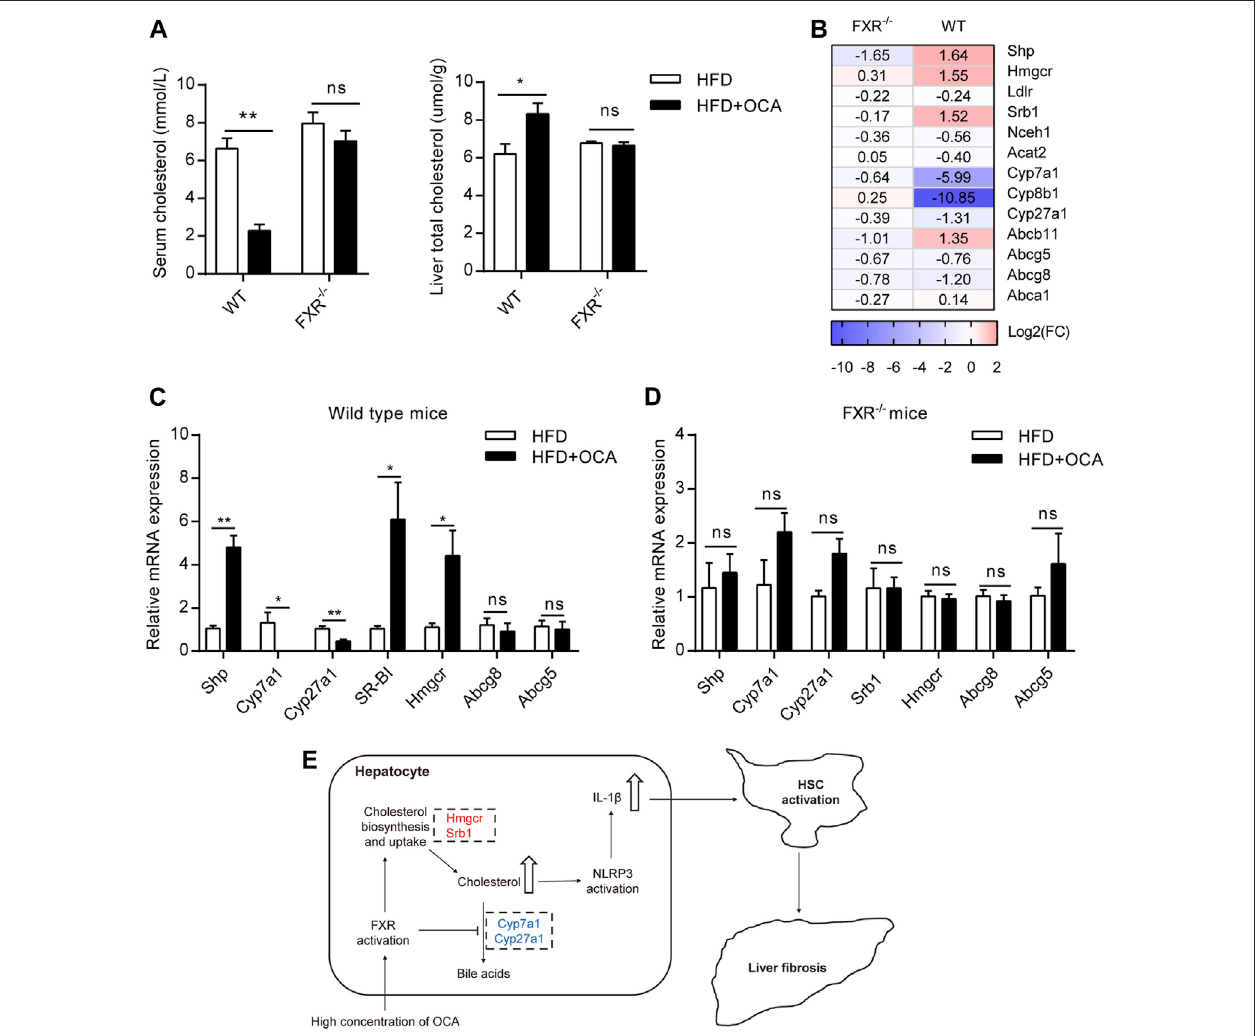
FIGURE 5 | High-dose OCA disrupted liver cholesterol metabolism via FXR activation. Mice were administered with OCA as described in Figure 2 . (A) Left panel, serum cholesterol; right panel, liver total cholesterol. (B) Fold change (FC) of FXR-target genes and cholesterol metabolism genes, as determined by RNA-seq. (C) Relative mRNA expression ofgenes involved incholesterol metabolismin WT mice,as determined by real-time quantitative PCR(qPCR). (D) Relative mRNA expression determined by qPCR in FXR − / − mice. (E) Molecular pathways of high-dose OCA-induced hepatic fi brosis (upregulated genes are shown in red; downregulated genes are shown in blue). ns, not signi fi cant; *, p ＜ 0.05; **, p ＜ 0.01; ***, p ＜